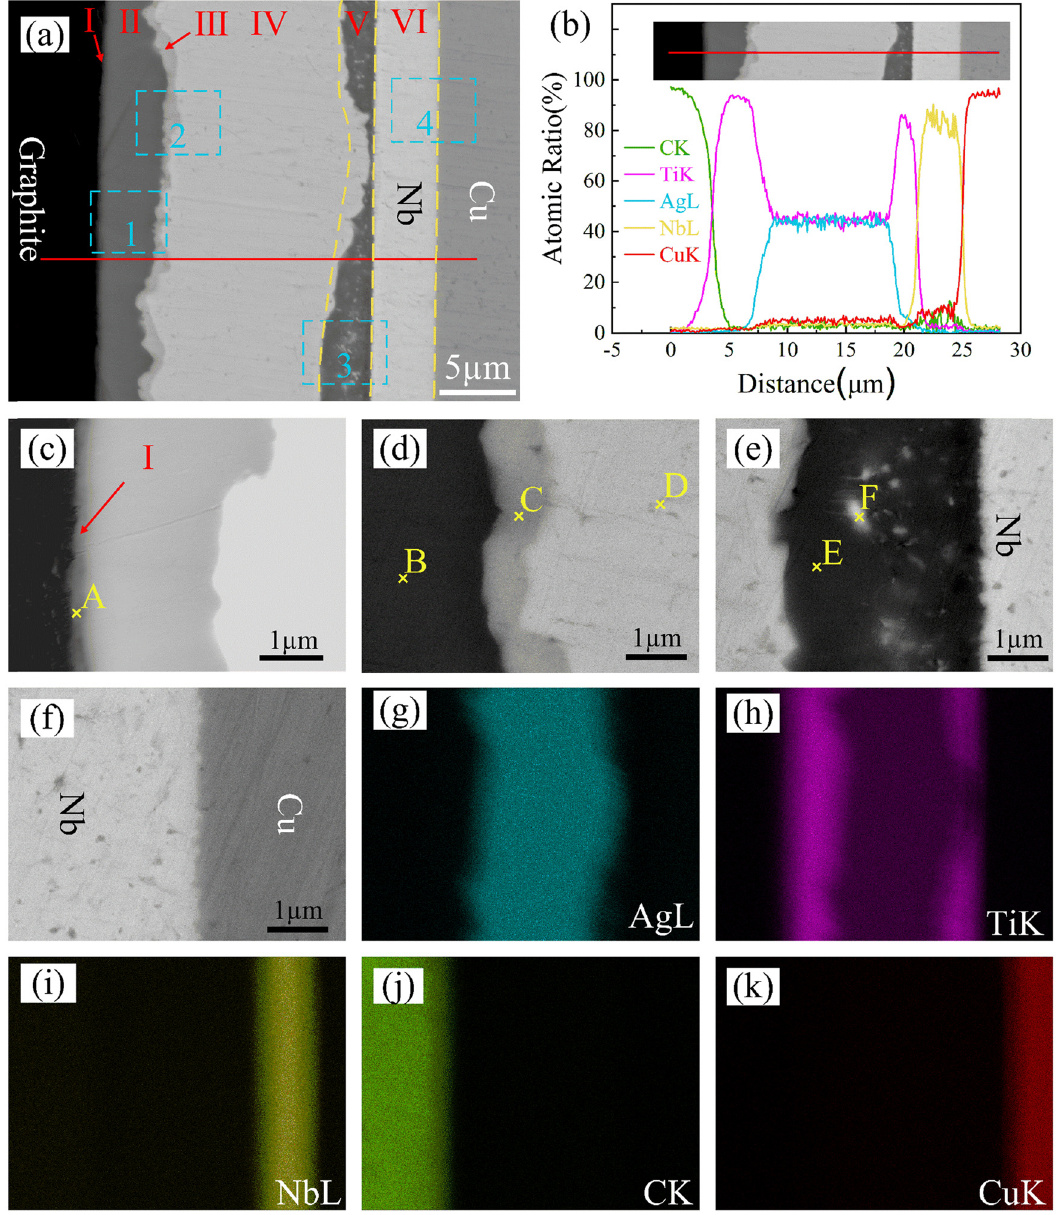
Figure 2: Microstructure ( a ) , enlarged view of blue box 1 – 4 ( c – f ) , and elemental analysis results ( b, g – k ) of the graphite/Cu joint bonded with Nb/Ag/Ti composite interlayer at 850°C for 30